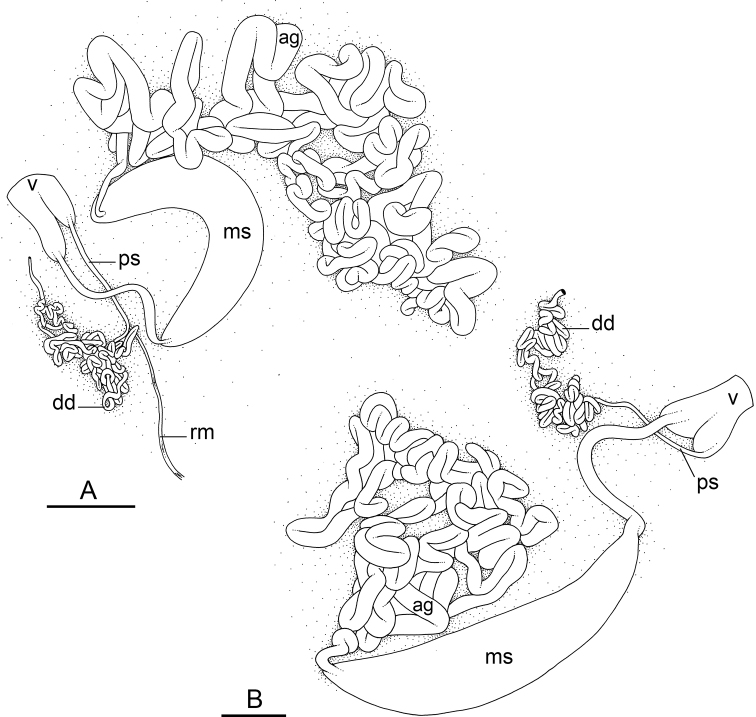
Anterior, male, copulatory apparatus, Peronia
peroniiA Mauritius [3605] (MNHN-IM-2019-1606) B Papua New Guinea, Madang [5472] (MNHN-IM-2013-14052). Scale bars: 10 mm (A), 5 mm (B). Abbreviations: ag accessory penial gland, dd deferent duct, ms muscular sac, ps penial sheath, rm retractor muscle, v vestibule.